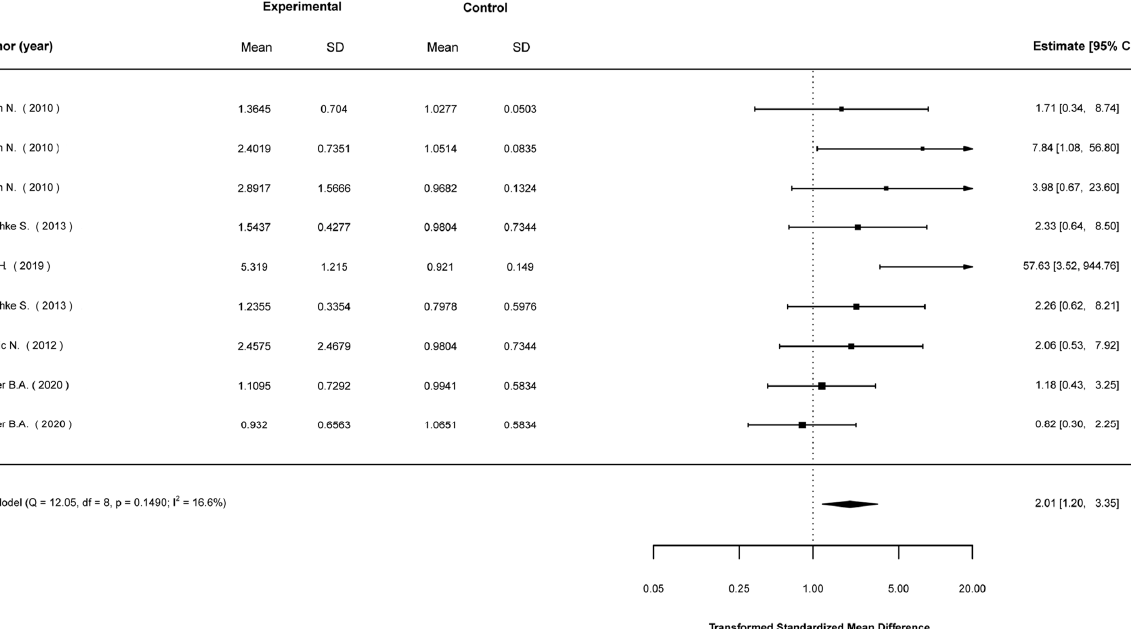
Figure 5. Findings of random-effects meta-analysis on the effects of EPS on PGC1a compared to non-stimulated cells. Results shown are transformed standardized mean differences and 95% confidence intervals, as an estimate of the log odds ratio. Differences greater than 1.00 favour the EPS cells compared to non-stimulated control cells [13,17,21,50,52,58].